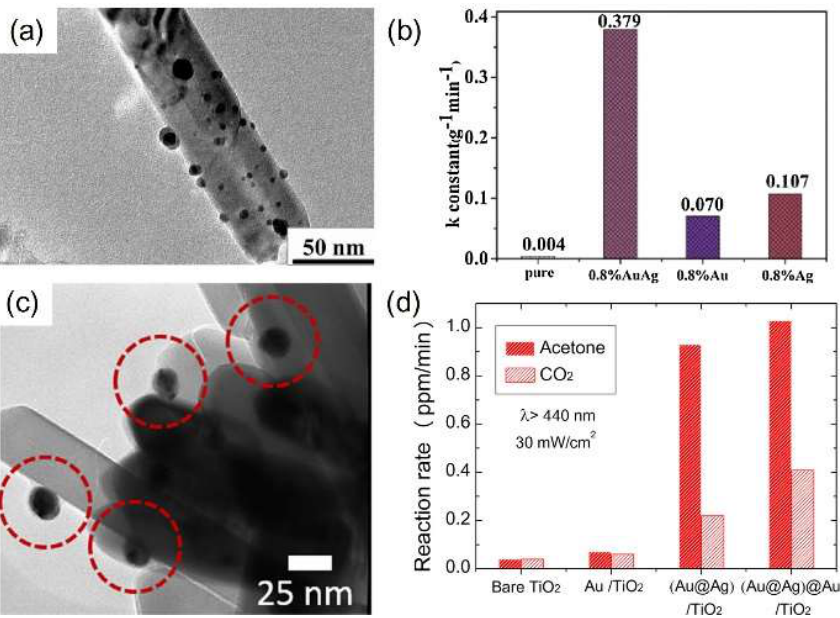
Figure 4. ( a ) TEM image of AuAg/ZnO. ( b ) Photocatalytic rate of different catalysts. Copyright 2017 Elsevier. ( c ) TEM image of (Au@Ag)@Au decorated TiO 2 . ( d ) Photocatalytic performance of the contrast samples under visible light irradiation. Copyright 2017 Elsevier.